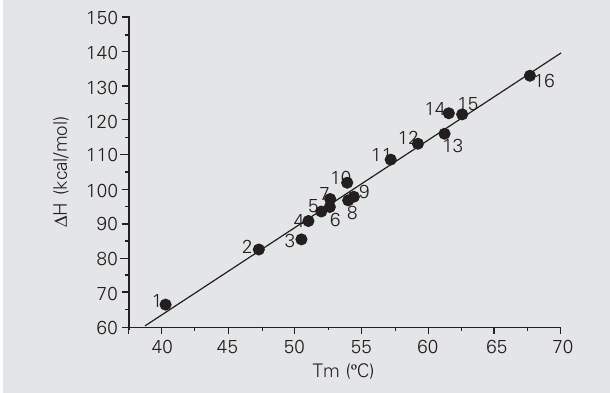
Figure 5. ∆ H cal versus Tm ( º C) at different pH values, concentrations of sorbitol at pH 3.00, of guanidinium hydrochloride at pH 3.00, of urea at pH 3.00, and different buffers. Protein concentration was 1.0 mg/ml except when the influence of protein concentration was tested. NaCl (0.2 M) was used in one experiment at pH 3.00. In all experiments the buffer was 0.1 M ß-alanine except when glycine or acetate was used. The slope was ∆ Cp = 2.50 ± 0.07 kcal mol -1 K -1 . Run conditions: 1) 1.00 M guanidinium hydrochloride, pH 3.00; 2) 0.70 M guanidinium hydrochlo- ride, pH 3.00; 3) 0.50 M guanidinium hydrochloride, pH 3.00; 4) 0.50 M urea, pH 3.00; 5) pH 2.70; 6) pH 2.80; 7) pH 2.85; 8) pH 2.90; 9) 0.20 M NaCl, pH 3.00; 10) ß-alanine, pH 3.00; 11) pH 3.20; 12) glycine, pH 3.00; 13) 0.1 mg/ml protein, pH 3.70; 14) acetate buffer, pH 3.00; 15) 1.0 M sorbitol, pH 3.20; 16) 2.0 M sorbitol, pH 3.14. In all experiments, ∆ H cal was equal to ∆ H vH .